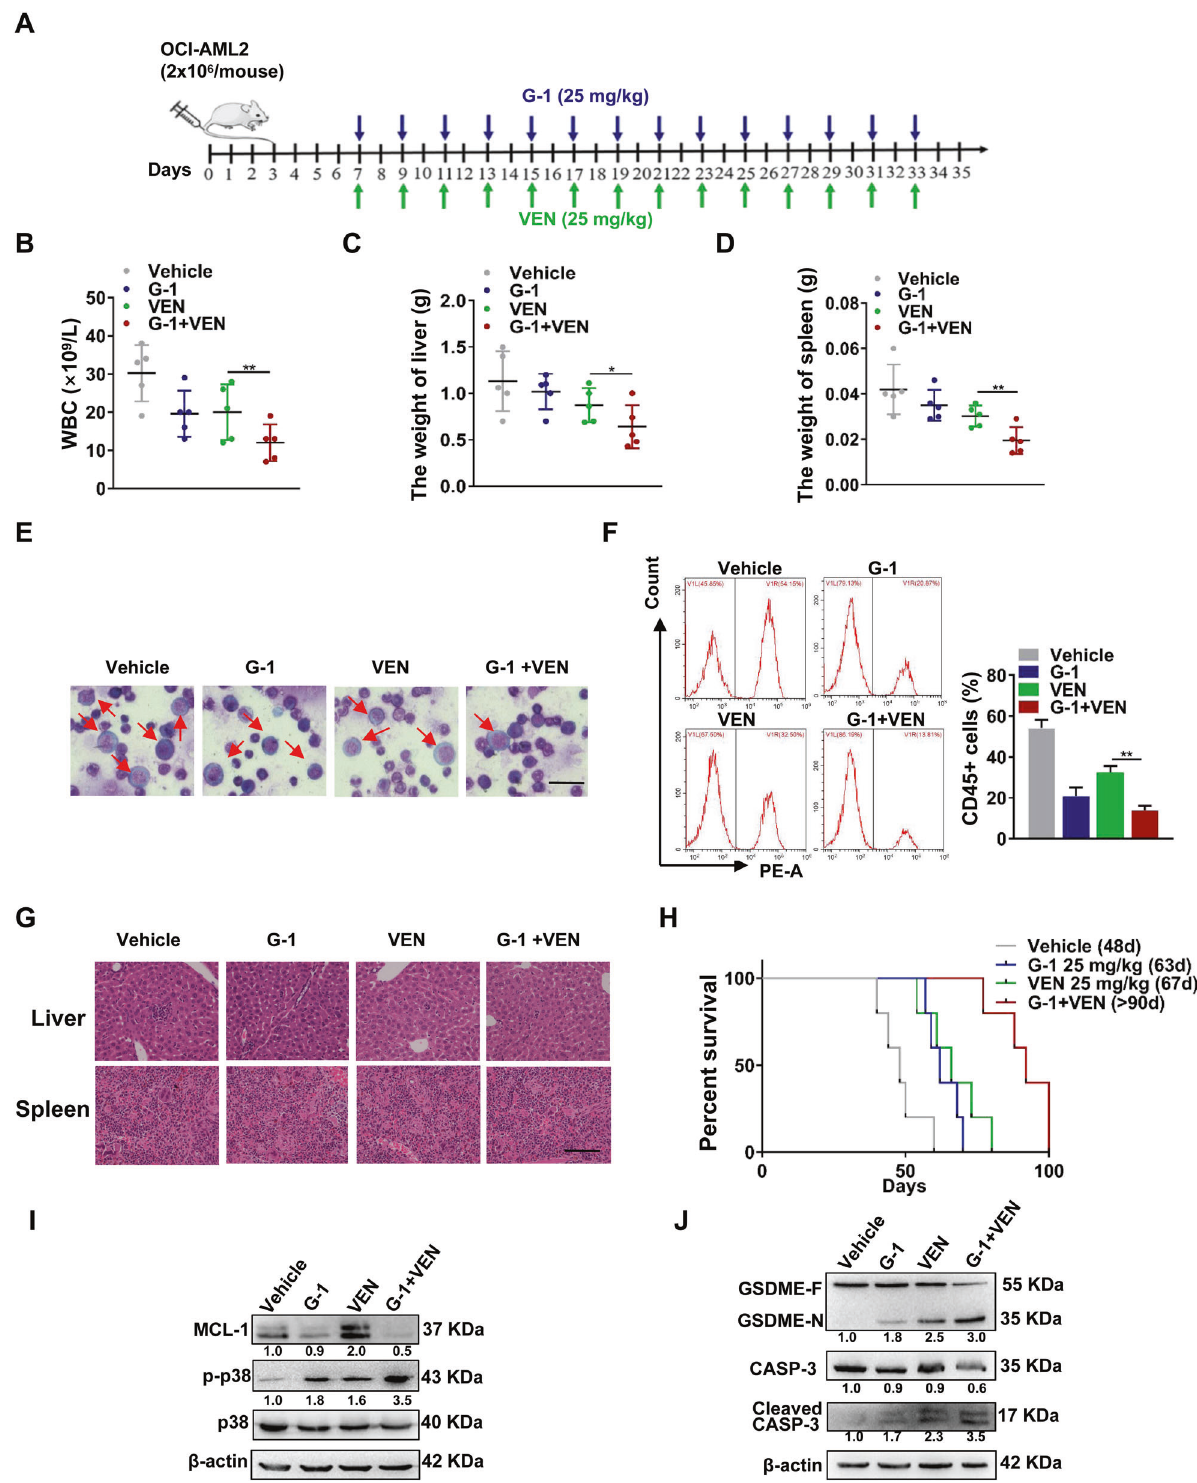
Fig. 7 The combination treatment synergistically impairs leukemogenesis in vivo. A Treatment schedule of leukemia mice model. B The WBC count was recorded. C , D Weights of the liver and spleen of mice were measured. E Wright ’ s staining of immature cells from bone marrow (Scale bar, 25 μ m). F FCM analysis of human CD45 + leukemic cells. G H&E staining of representative liver and spleen in fi ltration (Scale bar, 50 μ m). H Kaplan – Meier analysis of the survival curves of the mice. I , J Western blotting of MCL-1, p-p38, GSDME-N, and cleaved CASP-3. The data are expressed as the mean ± SD ( n = 3). * p < 0.05, ** p < 0.01.